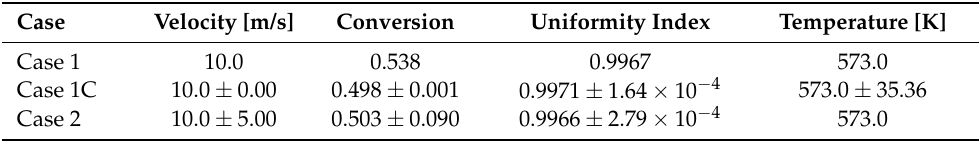
Table 4. Time-averaged results for inlet velocity, conversion at system outlet and uniformity index inside the monolith brick. The variation intervals reported are the standard deviations. Averages and standard deviations are recorded for the last second of a 10-second